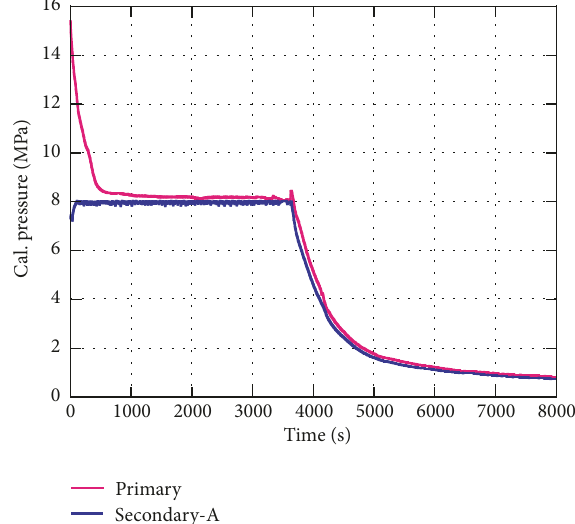
Figure 12: RELAP5 sensitivity analysis results for primary and SG secondary-side pressures in loop A.